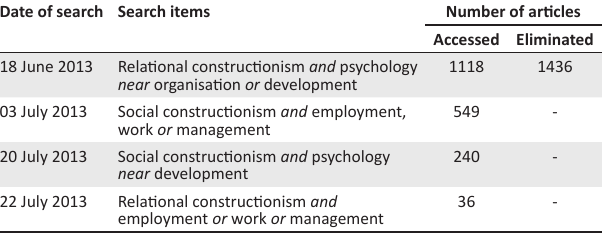
TABLE 1: The literature search-tracking